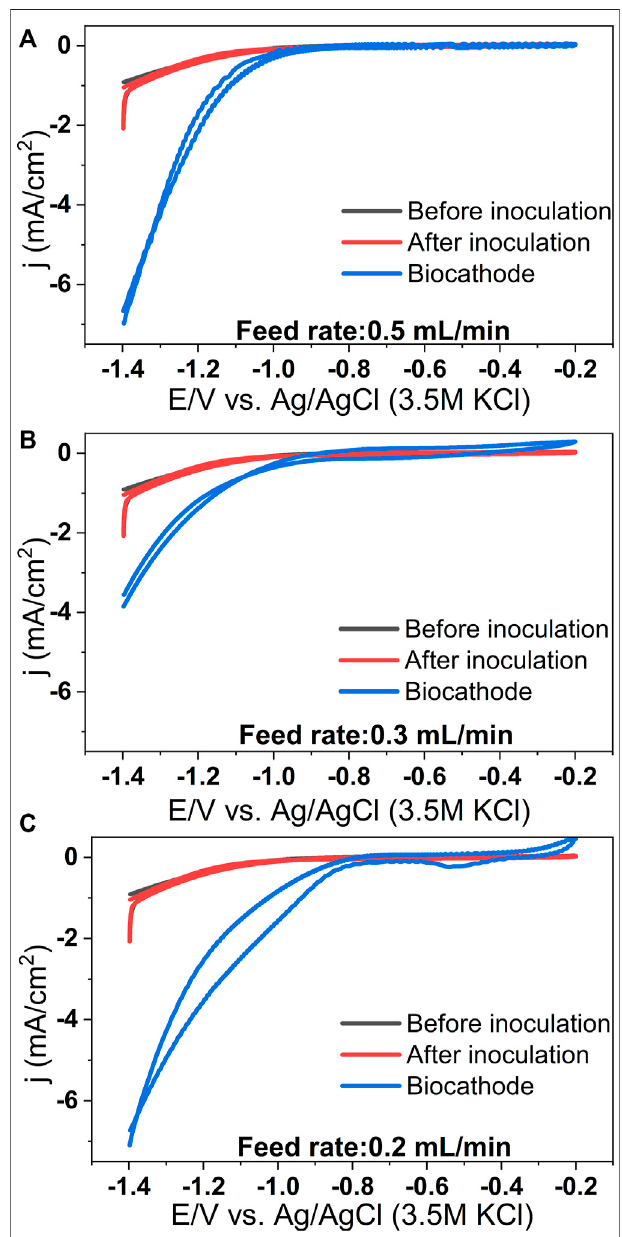
FIGURE 4 | Representative cyclic voltammograms recorded at different conditions for the MES reactors operated at biogas feed rates of 0.5 ml/min (A) , 0.3 ml/min (B) and 0.2 ml/min (C) . (Scan rate: 1 mV/s).